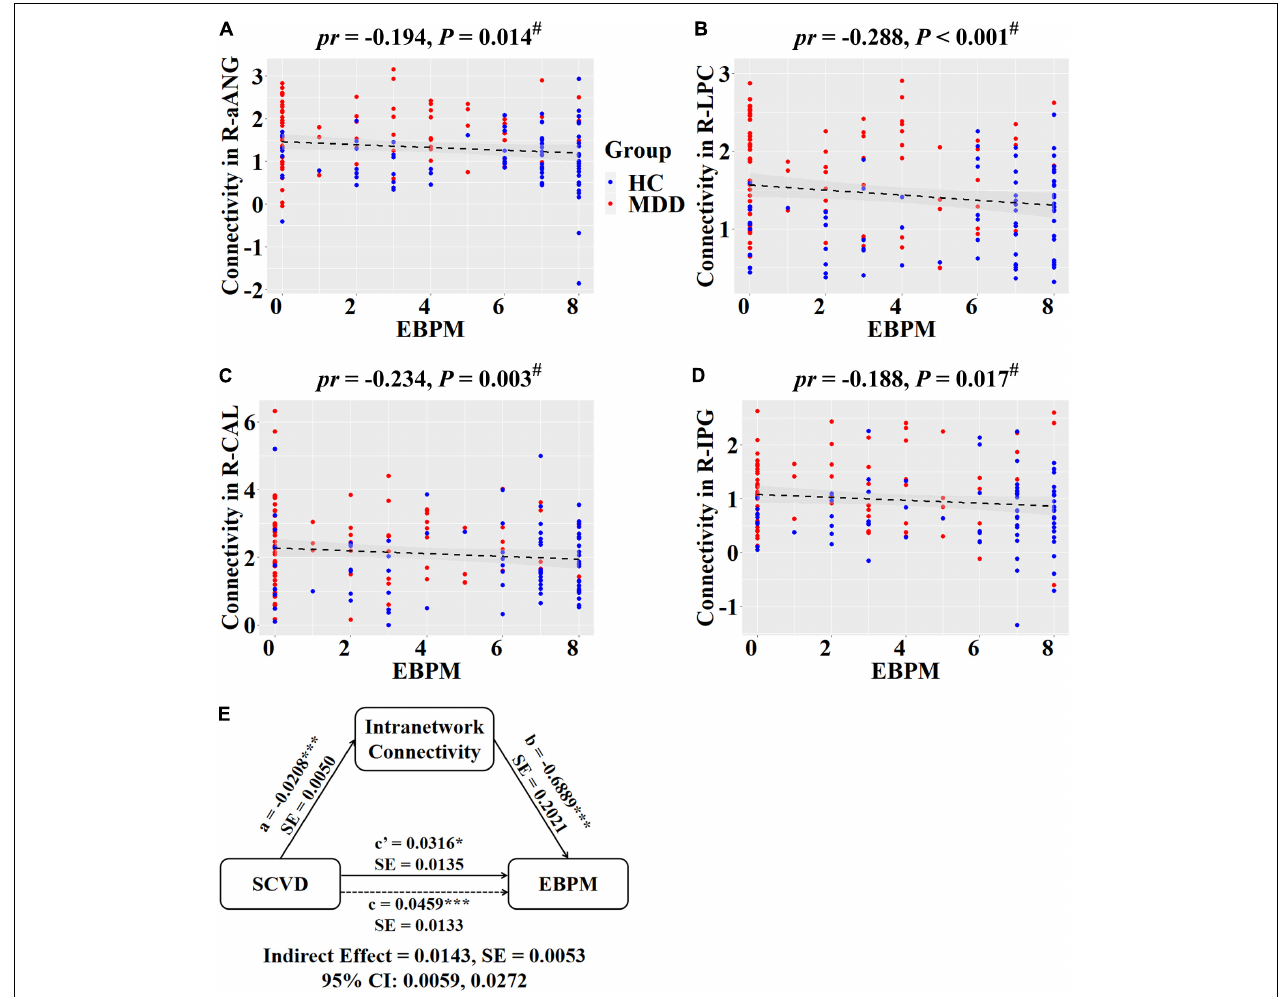
FIGURE 4 | Associations between SCVD, intranetwork functional connectivity, and EBPM in females. (A–D) Scatter plots show correlations between SCVD-related intranetwork connectivity and EBPM. (E) Graphical representation of the mediation analysis between SCVD and EBPM with first intranetwork functional connectivity component as the mediator: estimates of the mediated ( a × b ), direct ( c (cid:48) ), and total (c) effects. # P < 0.05, false discovery rate correction for multiple comparisons. * P < 0.05, *** P < 0.001. SCVD, serum concentration of vitamin D; EBPM, event-based prospective memory; aANG, anterior angular gyrus; LPC, lateral parietal cortex; CAL, calcarine sulcus; IPG, inferior parietal gyrus; HC, healthy controls; MDD, major depressive disorder; R, right; pr , partial correlation coefficient; SE, standard error; CI, confidence